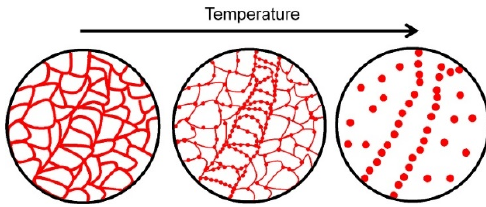
Figure 30. Schematic description of the microstructure evolution of the SLM samples during annealing. Red features represent Si-rich areas [67]. Copyright 2013. Adapted with permission from Elsevier Science Ltd. under the license number 4803720747532 (Figure 9 [67]), dated 7 April